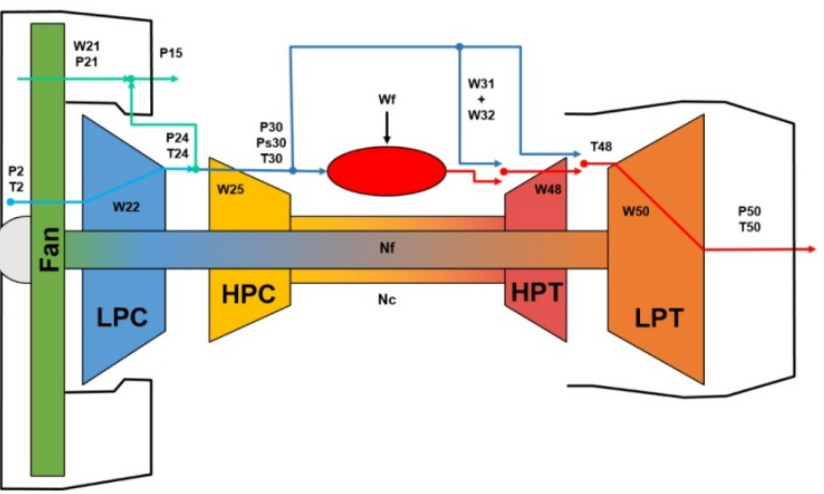
Figure 1. Schematic diagram of the CMAPSS turbofan engine. Reproduced from [9], MDPI: 2021.